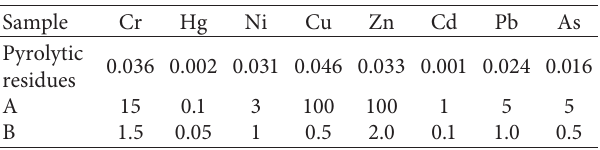
Table 2: Extraction toxicity of heavy metals in pyrolytic residues (mg/L).